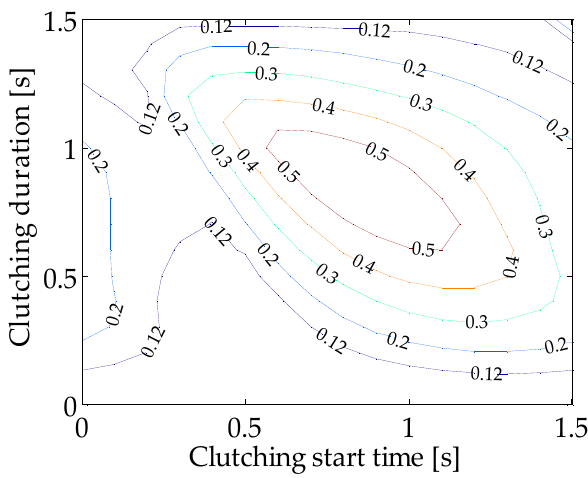
Figure 10. Relative capture width as a function of the clutching start time and clutching duration for the coulomb load at M p = 7 × 10 6 N·m and T = 3.0 s.